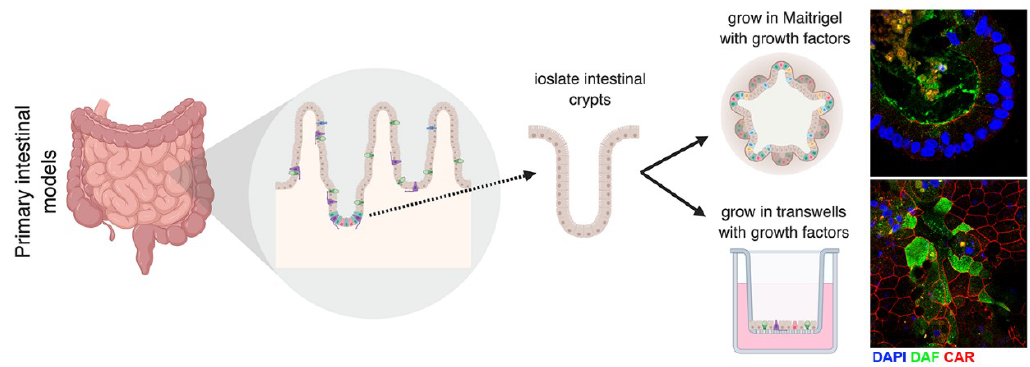
Figure 4. Primary intestinal models to study enterovirus infection. Intestinal crypts are isolated from the small intestine and plated either in Matrigel or on transwells. Crypts plated in Matrigel form a 3D structure called enteroids. When plated in Matrigel, enteroids have an “inside-out” structure, where the apical domain faces inward, and the basolateral domain is facing outward. When crypts are plated on transwells, they form a monolayer that has apical and basolateral polarity. Images shown are from crypts that were plated in Matrigel (top) or on a transwell (bottom) and stained with DAF (green) and CAR (red), which are involved in CVB attachment, uncoating, and